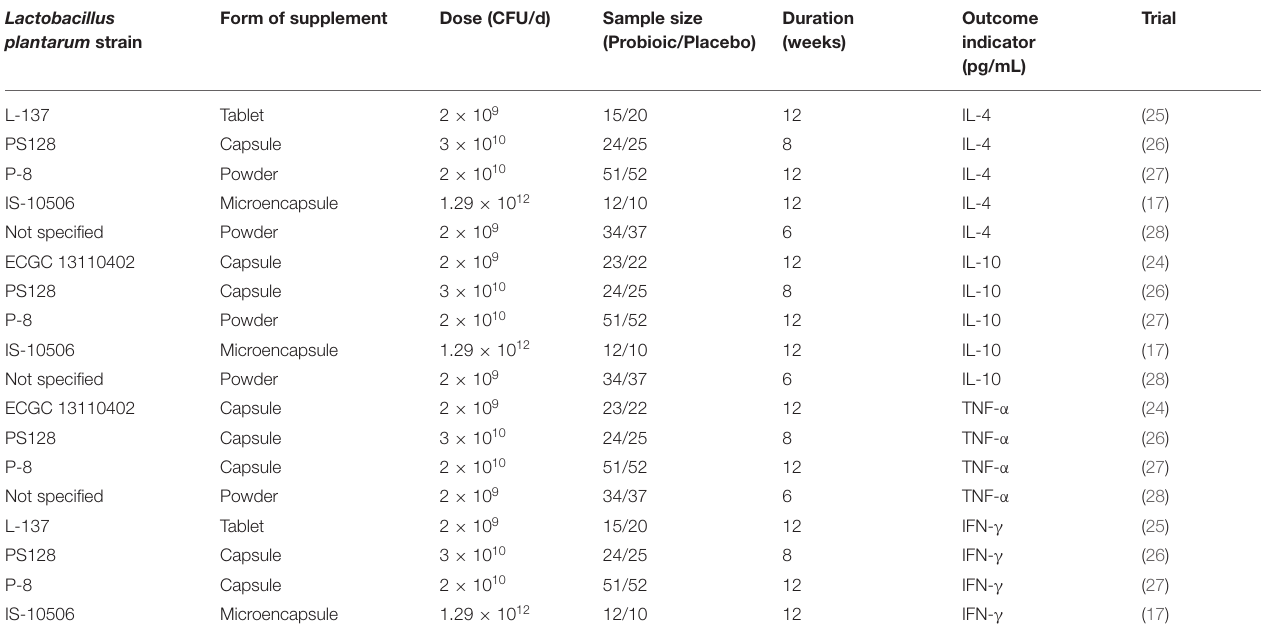
TABLE 1 | Extracted